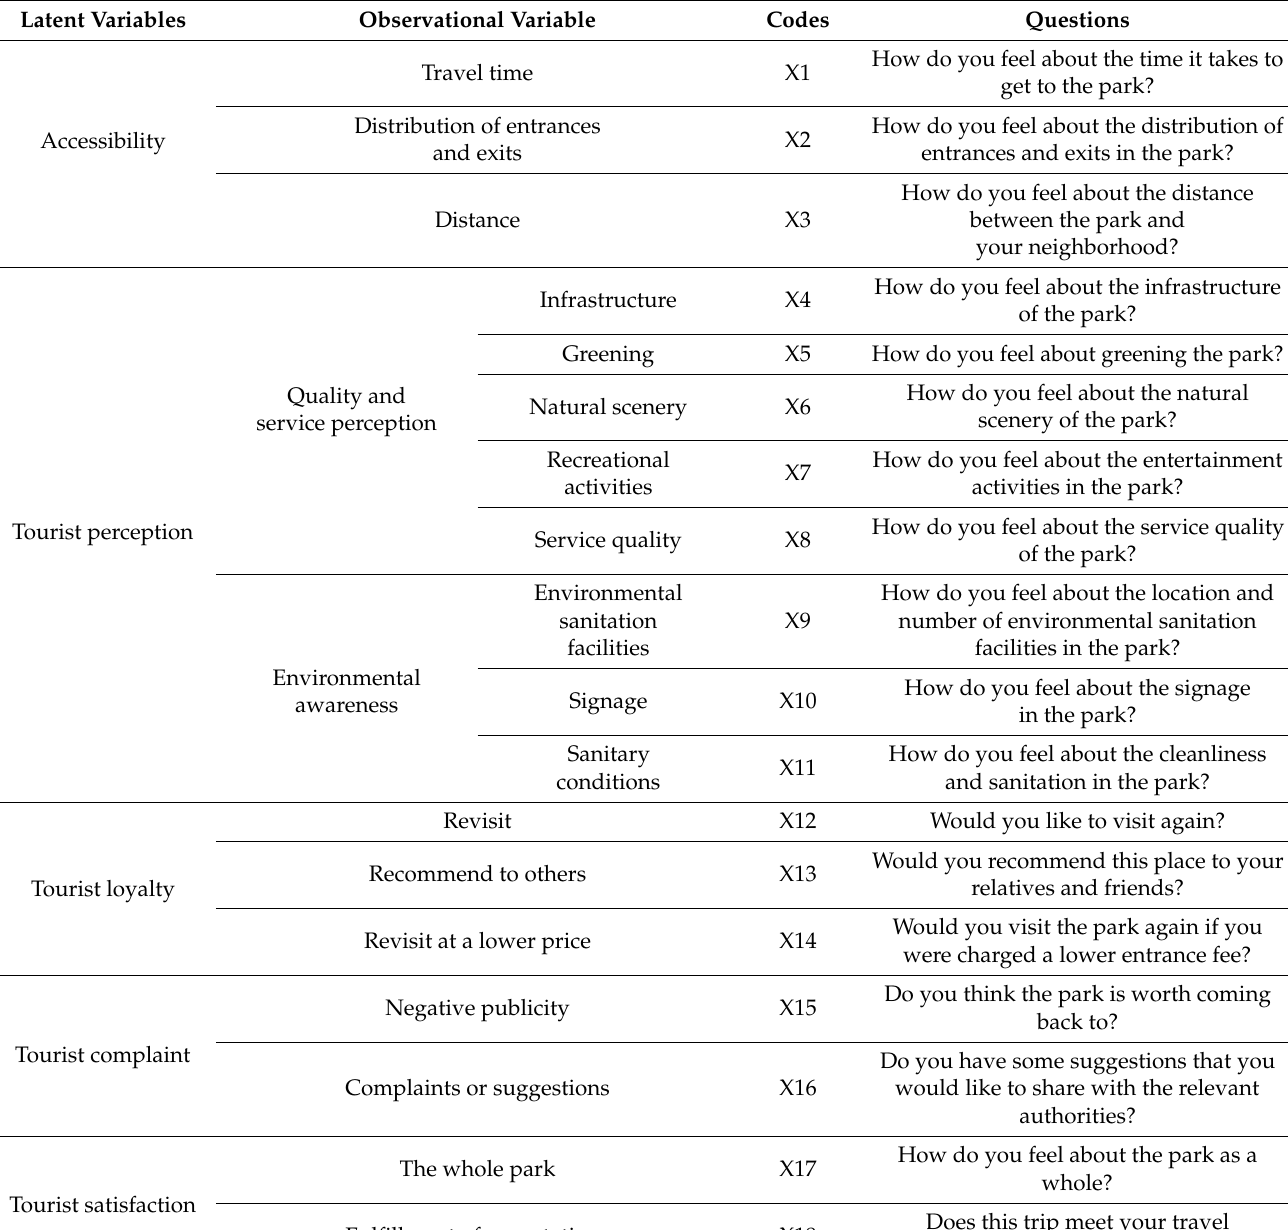
Table 2. Questionnaire